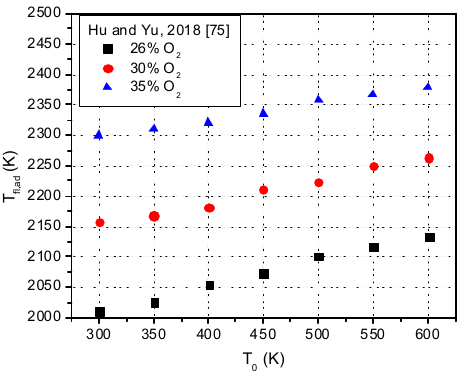
Figure 19. The adiabatic flame temperature variation with O 2 content for stoichiometric biogas-air mixtures.